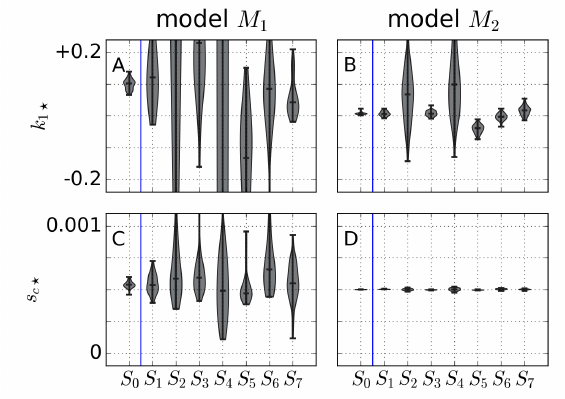
Figure 11. Radial distortion k 1 (cid:63) ( A , B ) and pixel size s c (cid:63) ( C , D ) for models M 1 ( A , C ) and M 2 ( B , D ) for angle A 1